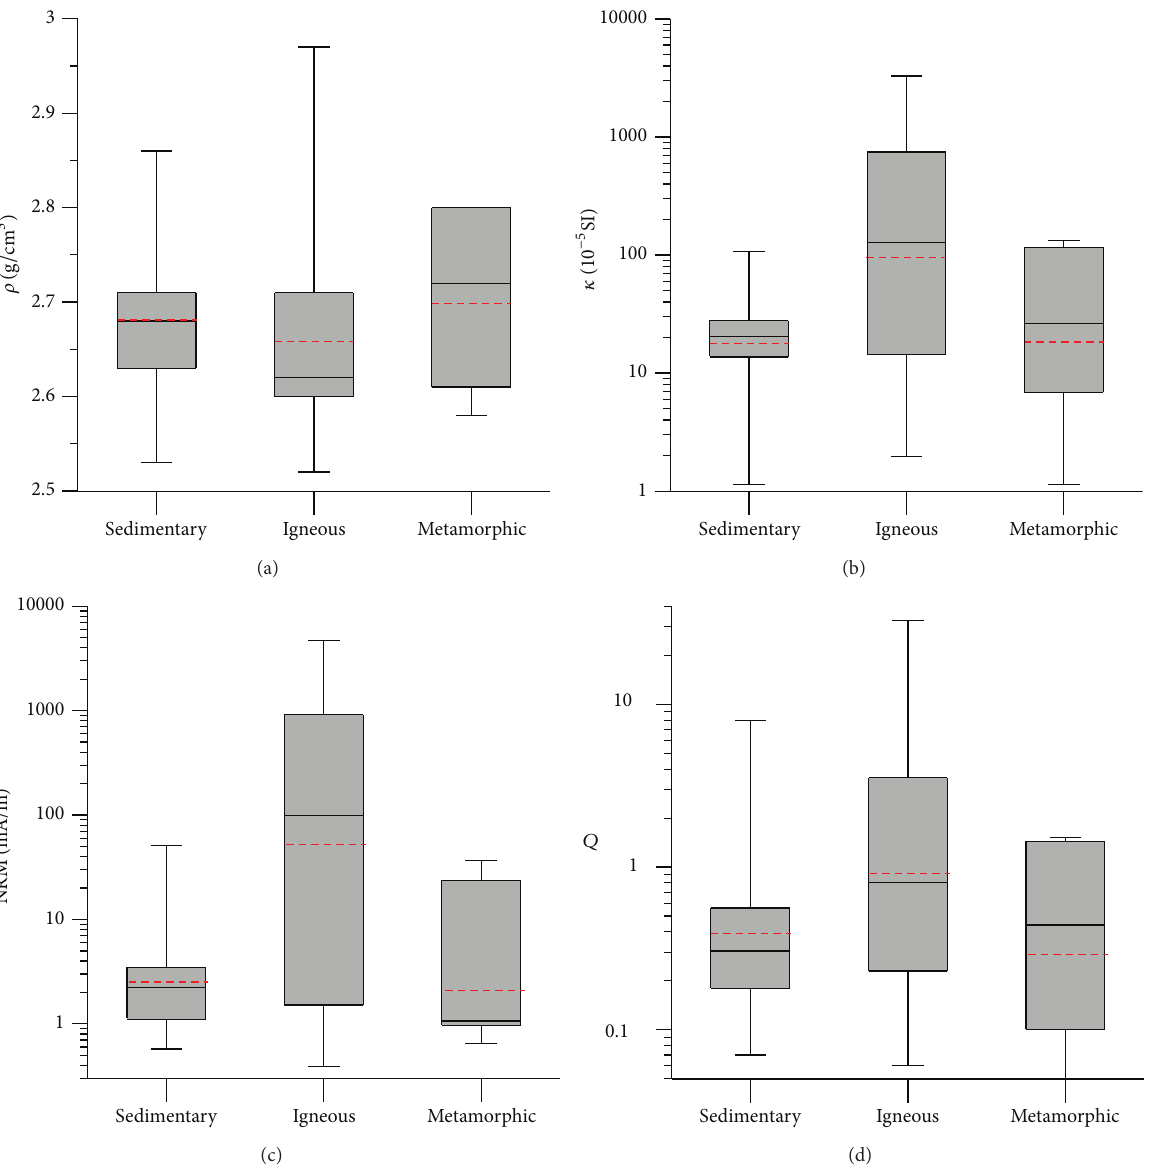
Figure 6: Box plot for (a) 𝜌 , (b) 𝜅 , (c) NRM, and (d) 𝑄 of sedimentary, igneous, and metamorphic rocks. Red dash lines indicate the average values of the corresponding petrophysical